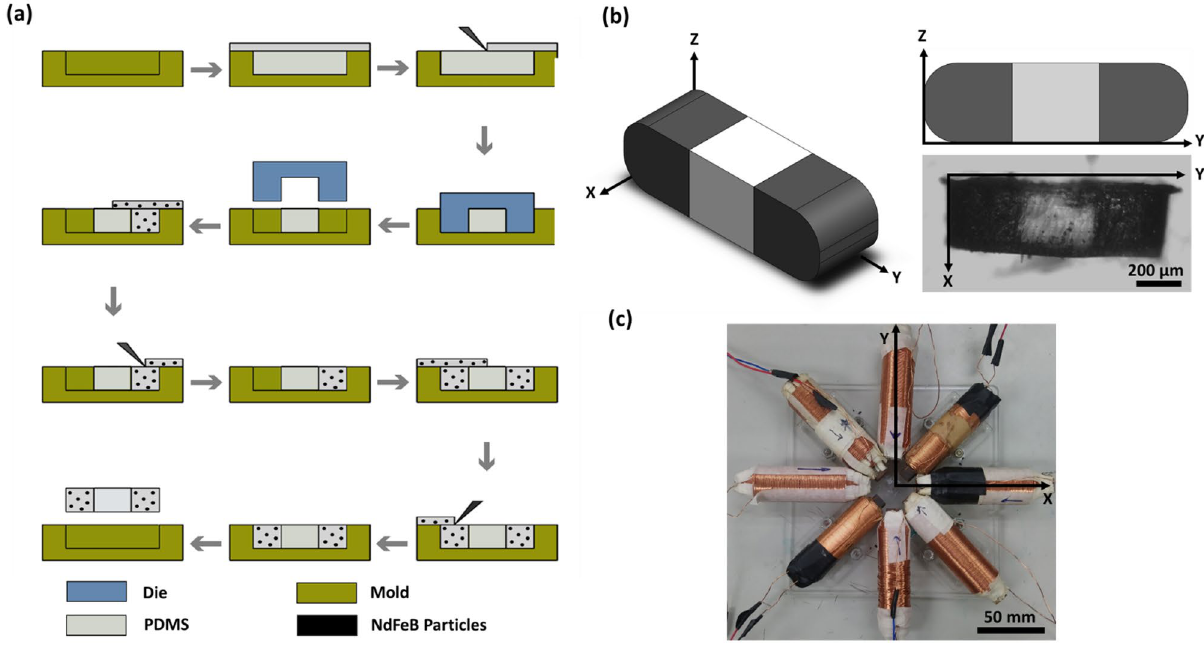
Figure 1. Fabrication of the aquatic microrobot and electromagnetic actuation system. ( a ) The fabrication process of the microrobot. ( b ) Geometry of the microrobot, top-left is the isometric view of microrobot design; top-right is the top front view of microrobot design; the bottom-right is the top view of the microrobot under microscope imaging. (length: 1000 µm, width: 300 µm, Height: 300 µm). ( c ) Setup of the in-house eight-coil electromagnet platform for the microrobot